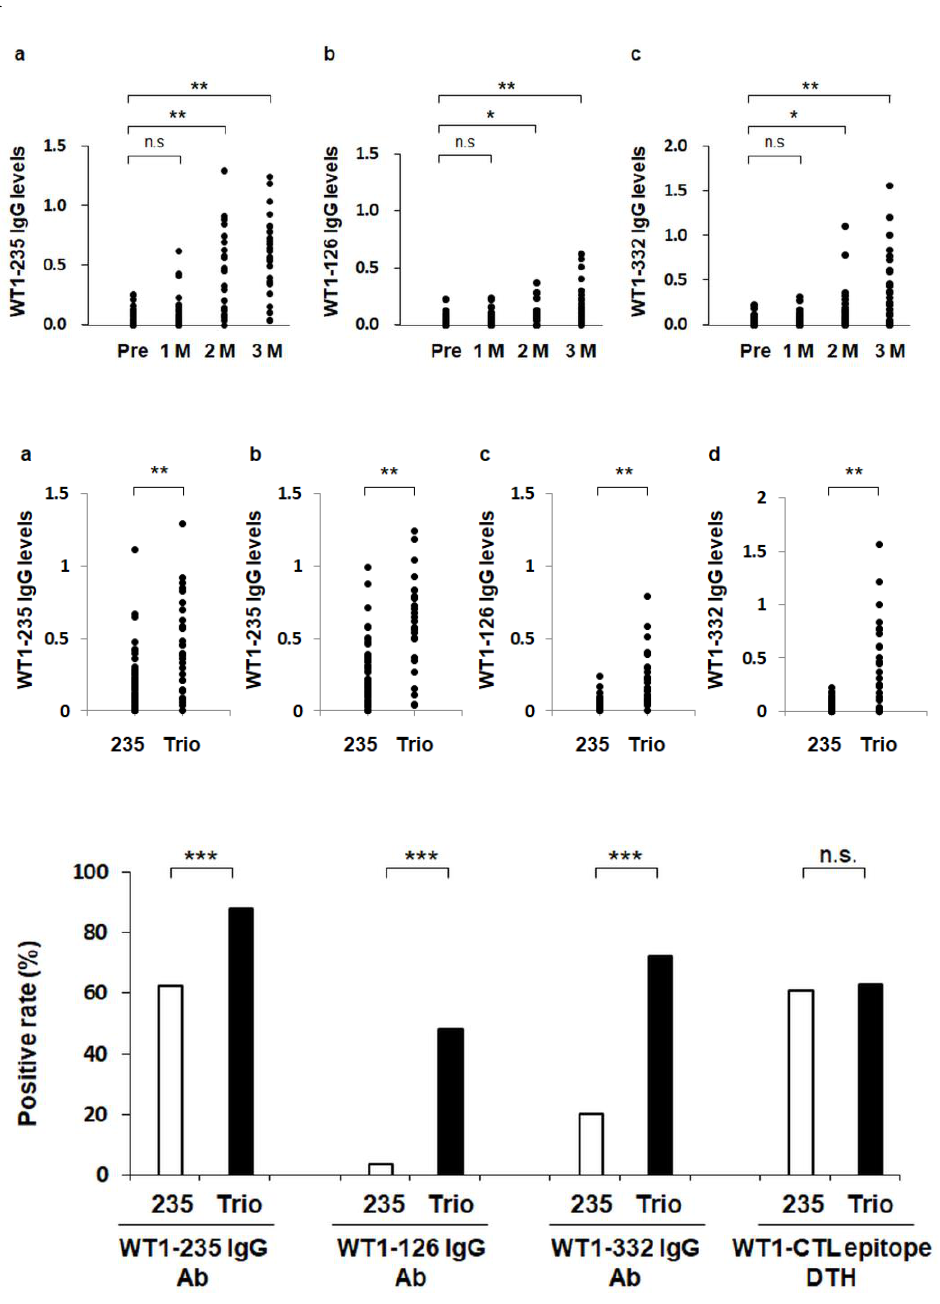
Figure 2. Enhanced induction of WT1-specific immune responses by WT1 Trio. Serum IgG antibody levels against WT1-126, WT1-235, and WT1-332 epitopes were measured using ELISA. *, p < 0.05; **, p < 0.01, and ***, p < 0.001. n.s., not significant. ( A ) Induction of IgG responses during